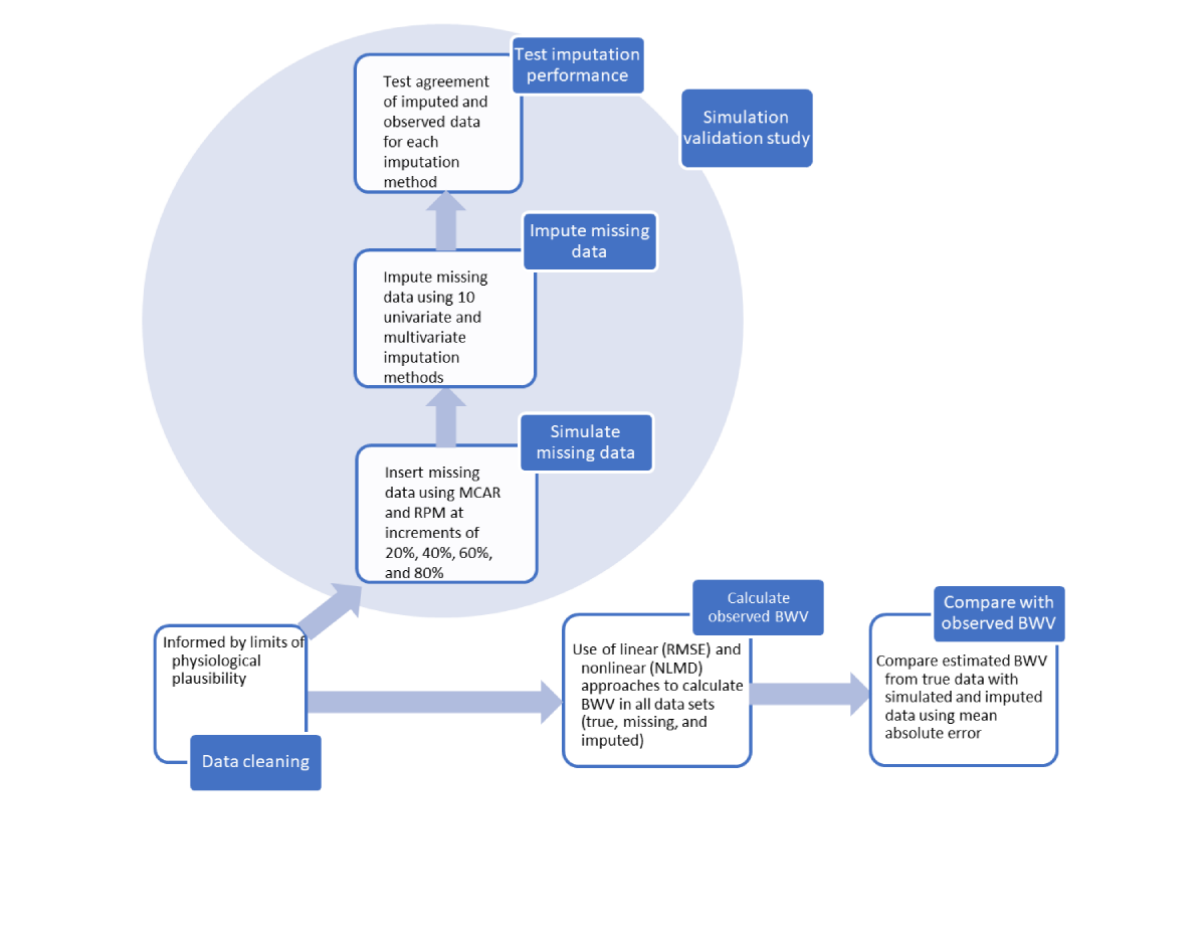
Figure 1. Study flow diagram. Outline of the study detailing the simulation validation study aimed to test imputation performance and calculation of linear and nonlinear body weight variability under conditions of true, missing, and imputed data sets with associated comparisons. BWV: body weight variability; MCAR: missing completely at random; NLMD: nonlinear mean deviation; RMSE: root mean square error; RPM: real patterns of